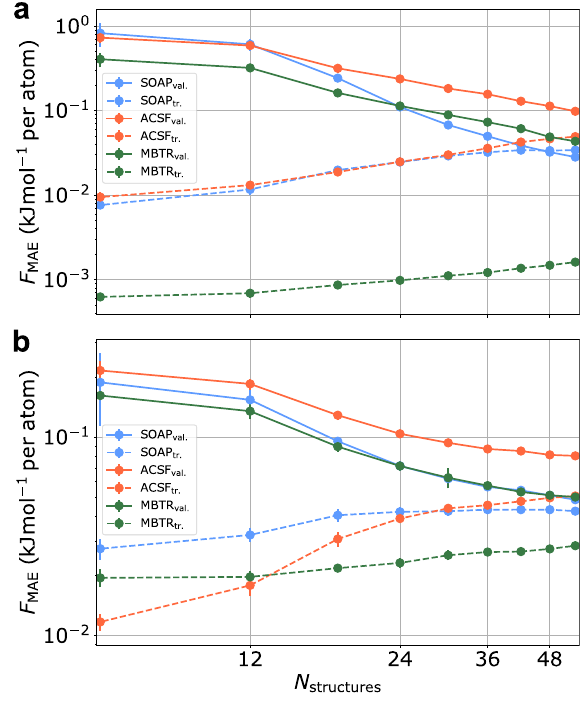
Fig. 2 Learning curves of F MAE (300 K) calculated for the training (dashed line) and the validation set (solid line) obtained with SOAP, MBTR and ACSF representations. Results are presented for GPR models obtained based on: a the empirical AIREBO force fi eld and b density-functional theory (PBE functional with pairwise van der Waals corrections) data, and are presented as a function of the number of crystal structures in the training set. Error bars are equal to the standard deviation of F MAE of training sets with different